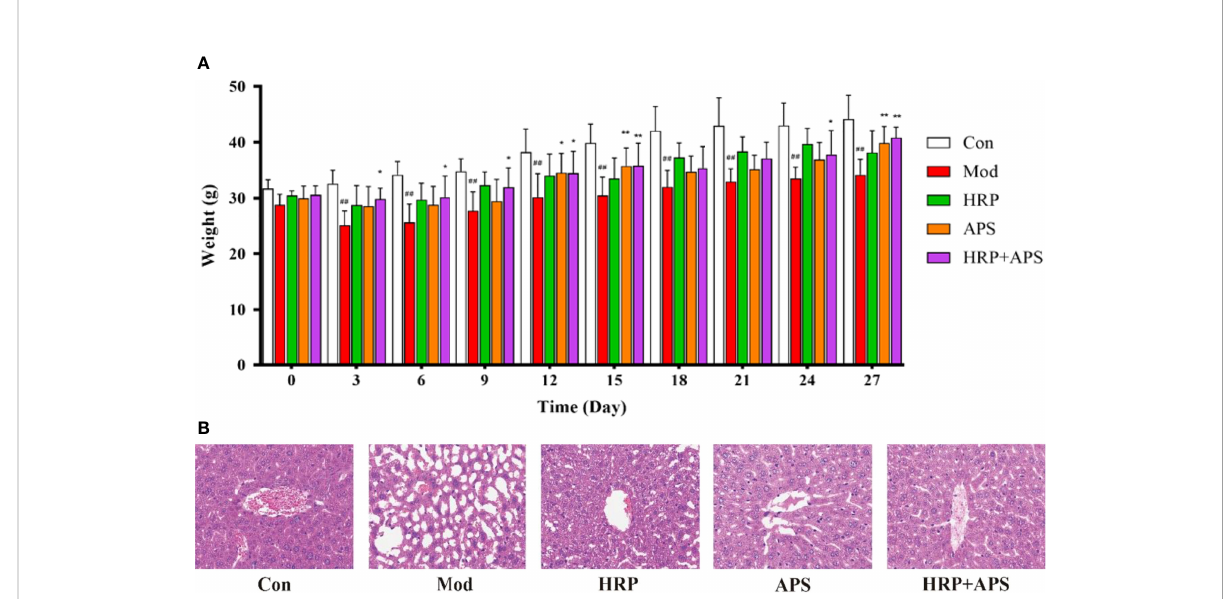
FIGURE 2 The effects of HRP, APS and the combination of HRP and APS on the body weight and histopathological change of liver in AFLD mice. (A) Weight changes of mice during the experiment. (B) Hematoxylin-eosin (H&E) staining of hepatocytes (Original magni fi cation, ×400, n = 3). Data are presented as mean ± SD (n = 6). ## P < 0.01 vs. Con; * P < 0.05 and ** P < 0.01 vs.